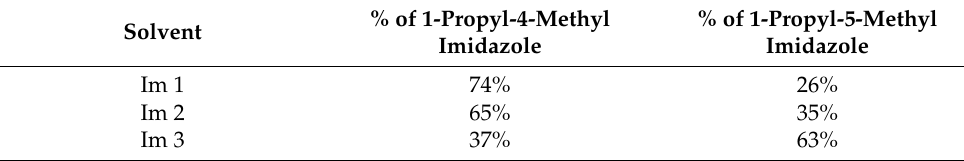
Table 1. The different isomer ratios in solvents used for TSEE experiments. Solvent % of 1-Propyl-4-Methyl % of 1-Propyl-5-Methyl Imidazole